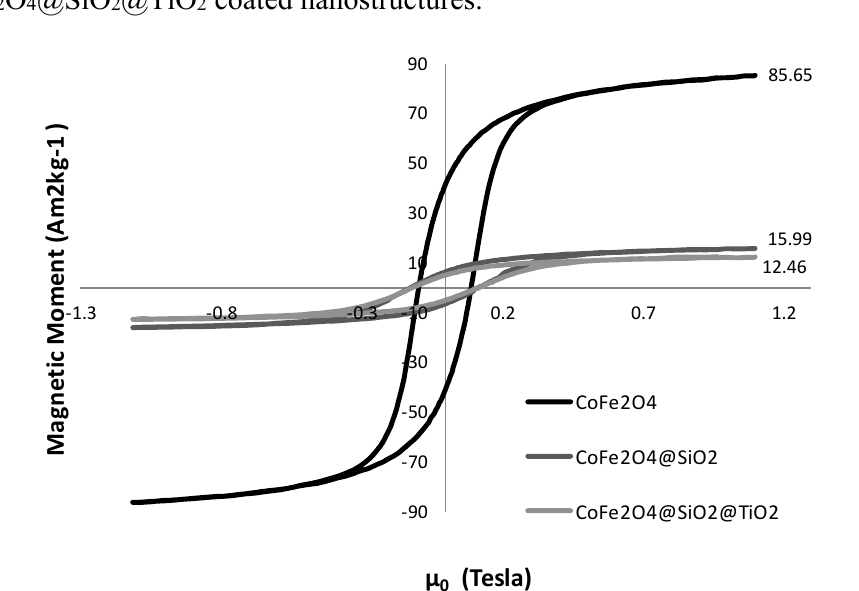
Figure 6. Vibrational Sample Magnetometer (VSM) curves of CoFe 2 O 4 , CoFe 2 O 4 @SiO 2 and CoFe 2 O 4 @SiO 2 @TiO 2 coated